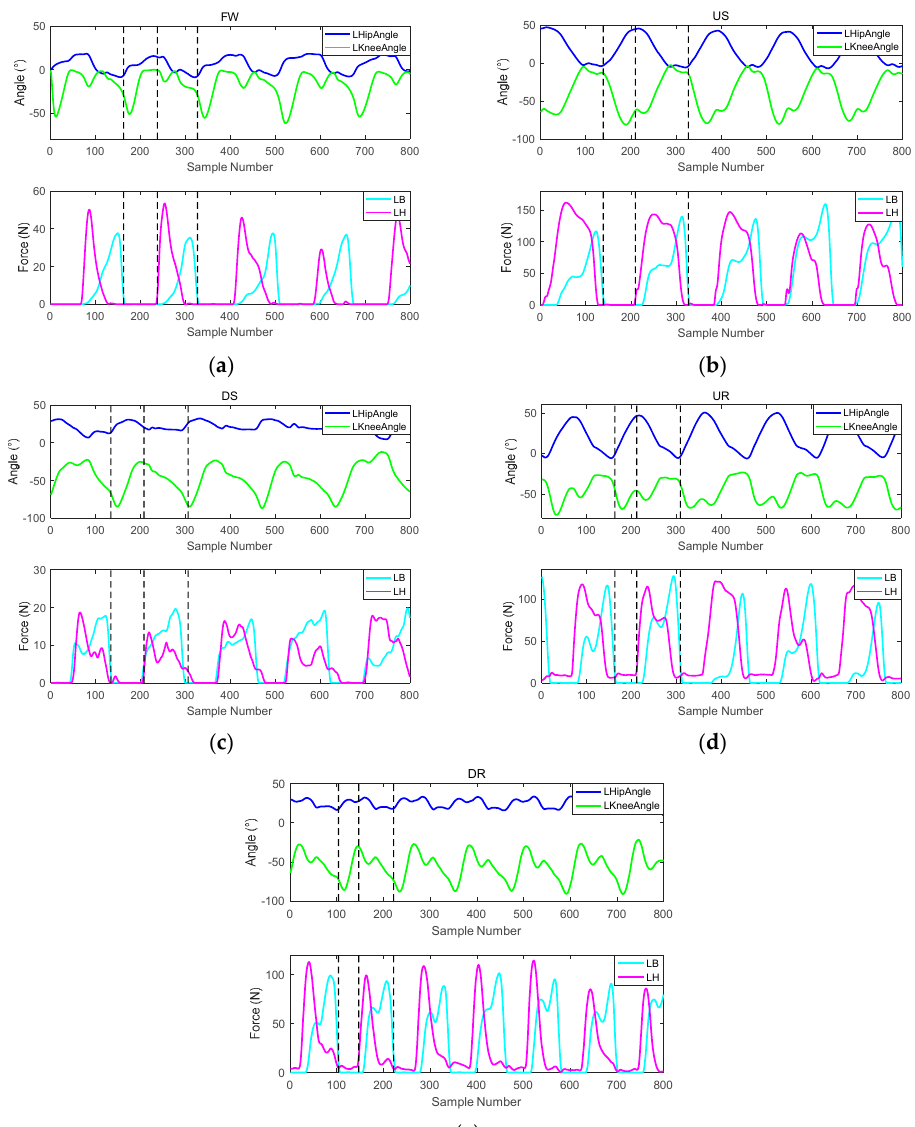
Figure 3. The lower limb information under different locomotion modes. ( a ) Flat Walking; ( b ) Up the Stairs; ( c ) Down the Stairs; ( d ) Up the Ramp; ( e ) Down the Ramp.